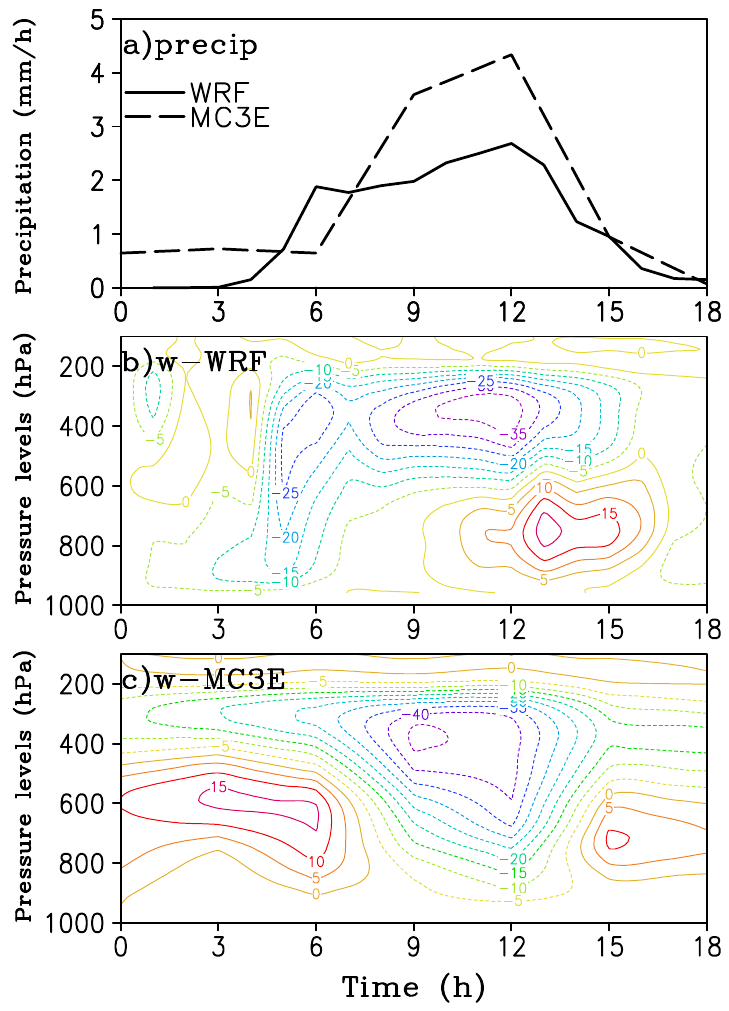
Figure 4. Comparison between 5 km-WRF simulation and observation. ( a ) Time series of precipitation rate (mm / h), solid line for WRF and dashed line for MC3E; ( b ) time-pressure slice of WRF-simulated vertical velocity (hPa / h); and c) same as ( b ) but for MC3E-analyzed vertical velocity (hPa / h). The model data is averaged over the 300 km-MC3E variational analysis domain for comparison.